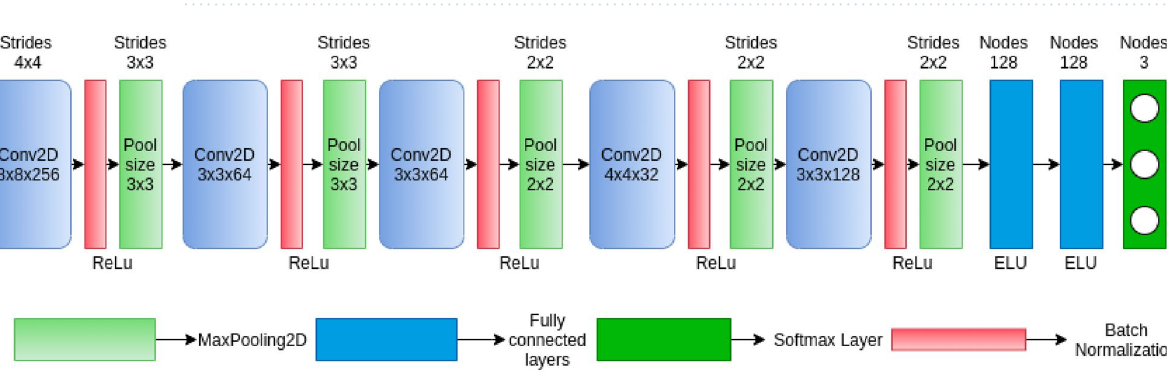
Figure 4. Architecture of the proposed CNN